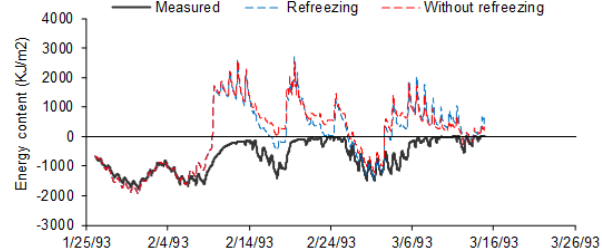
Figure 6. Comparisons of internal energy of snowpack in 1993 at the USU drainage farm. The wide solid line is the measured values. “Refreezing” represents the modeled internal energy of snowpack with new surface UEB model. “Without refreezing” represents the model without the refreezing scheme.